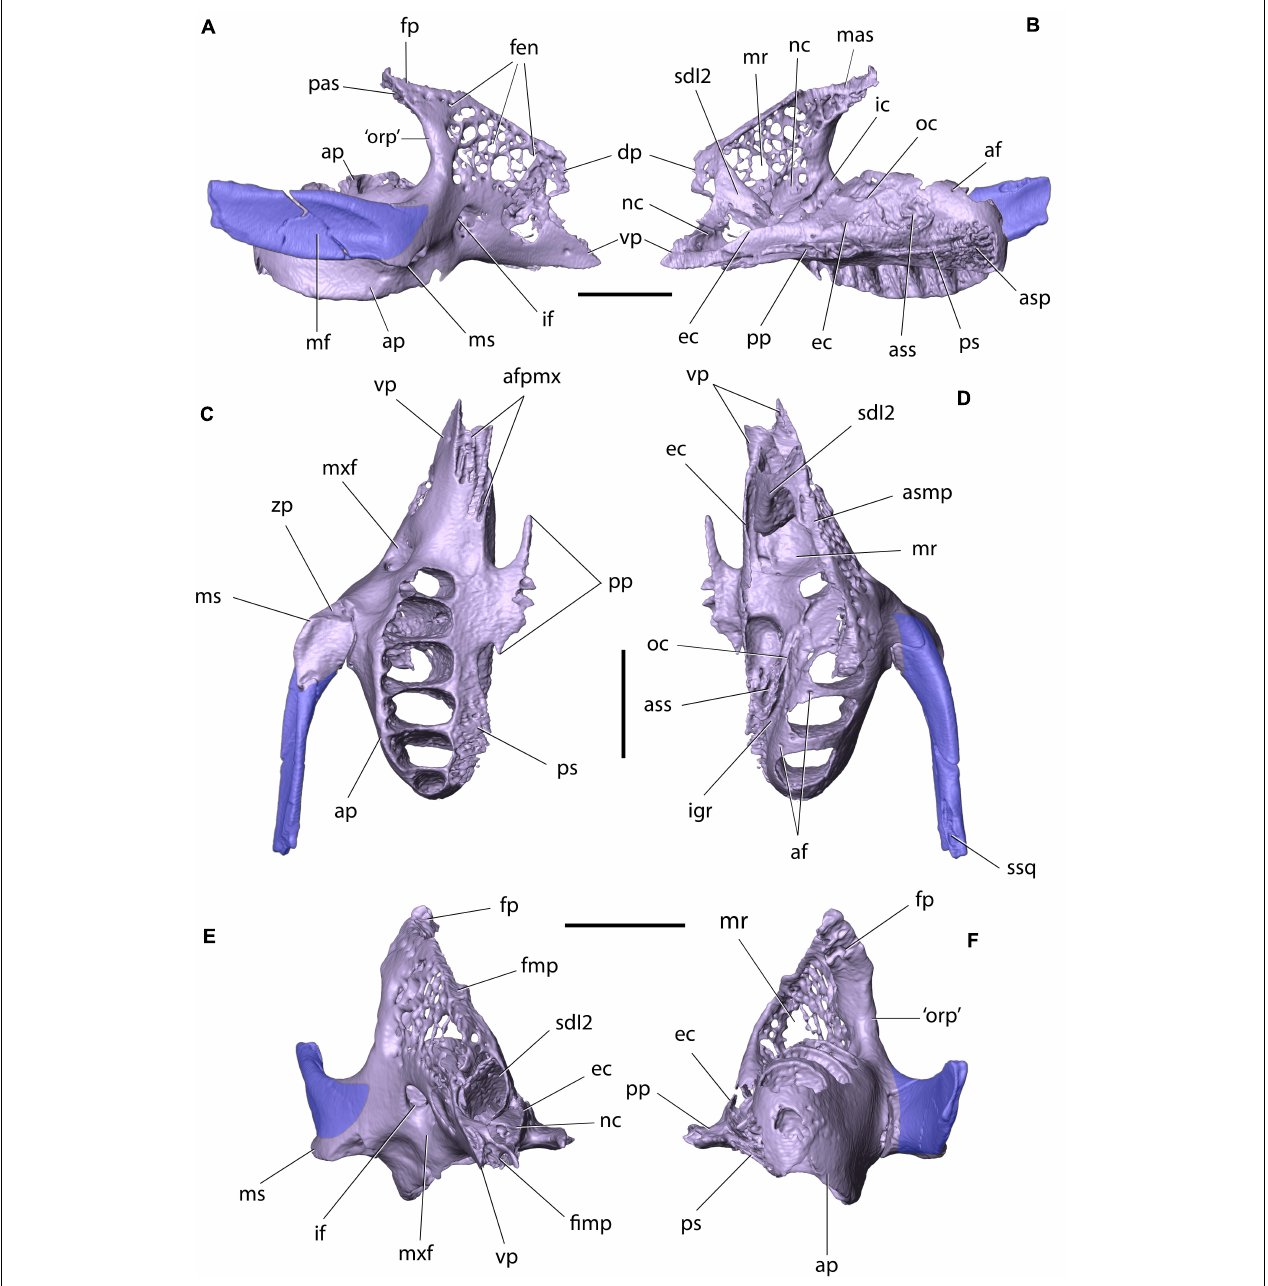
FIGURE 5 | Right maxilla and zygomatic of Palaeolagus haydeni (FMNH PM9476) in: (A) lateral, (B) medial, (C) ventral, (D) dorsal, (E) anterior, and (F) posterior views. Dentition removed for clarity. af, alveolar foramen; afpmx, articular facet for maxillary process of premaxilla; ap, alveolar process; asp, articular surface for horizontal lamina of palatine; ass, articular surface for ethmoidal process of presphenoid; dp, dorsal prong; ec, ethmoidal crest; fen, fenestrations; fimp, fissure for maxillary process of premaxilla; fmp, facet for maxillary process of frontal; fp, frontal process; ic, infraorbital canal; if, infraorbital foramen; igr, infraorbital groove; mas, dorsomedial articular surface of frontal process; mf, masseteric fossa; mr, maxillary recess (sinus); ms, masseteric spine; mxf, maxillary fossa; nc, nasolacrimal canal; oc, orbital crest; ‘orp’, ‘orbital process’ (posterior part of the corpus); pas, posterior articular surface of frontal process; pp, palatine process; ps, palatine shelf; sdI2, sheath for dI2; ssq, sulcus for zygomatic process of squamosal; vp, ventral prong; zp, zygomatic process. Scale bars = 5 mm.